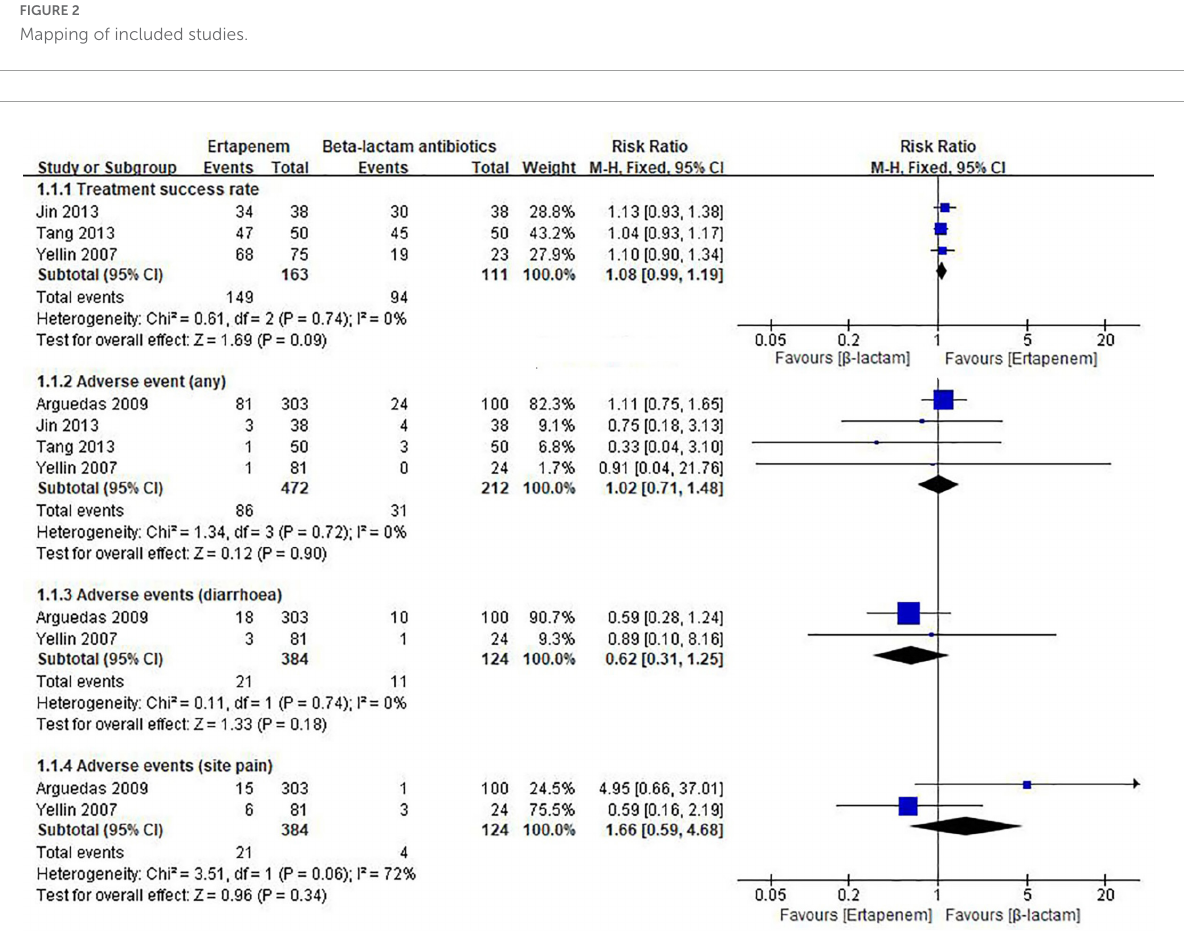
FIGURE3 Meta-analysis for ertapenem vs. β -lactam antibiotics in